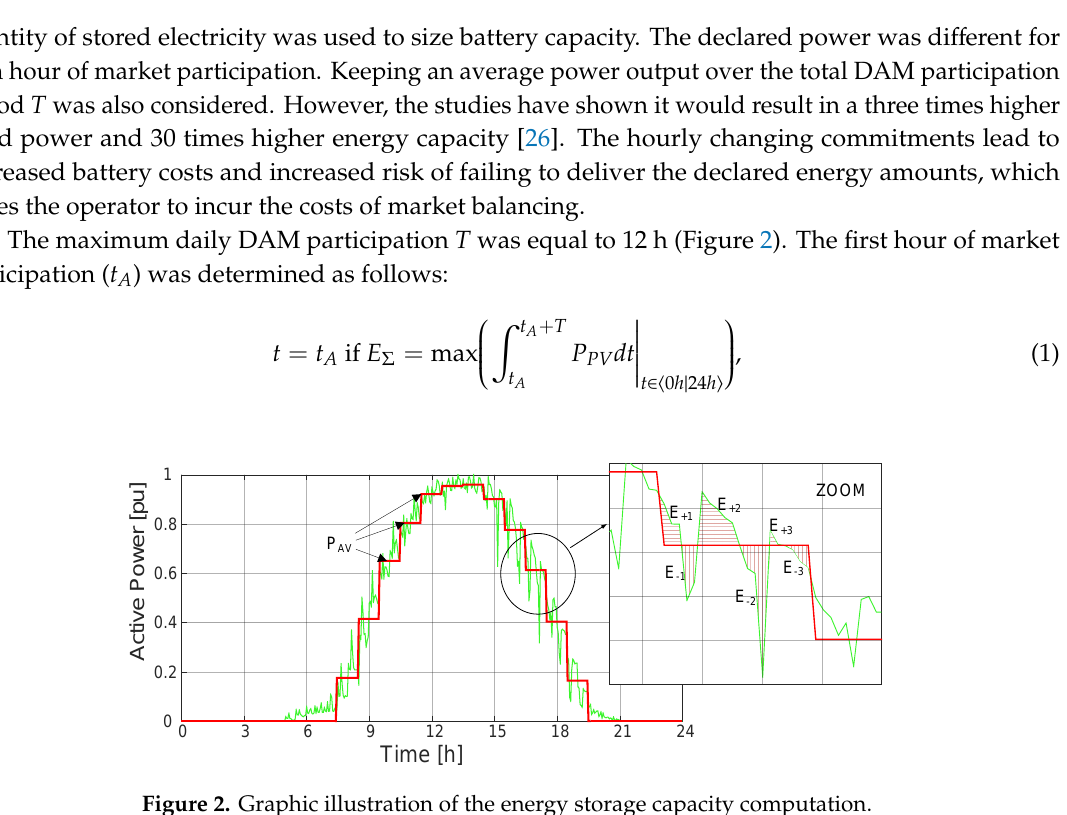
Figure 2. Graphic illustration of the energy storage capacity computation.